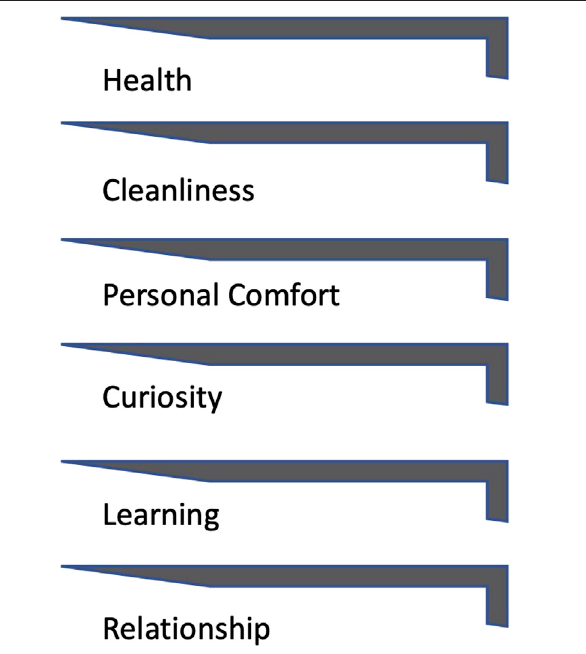
FIGURE 4 | Hierarchy model of researcher prioritizing